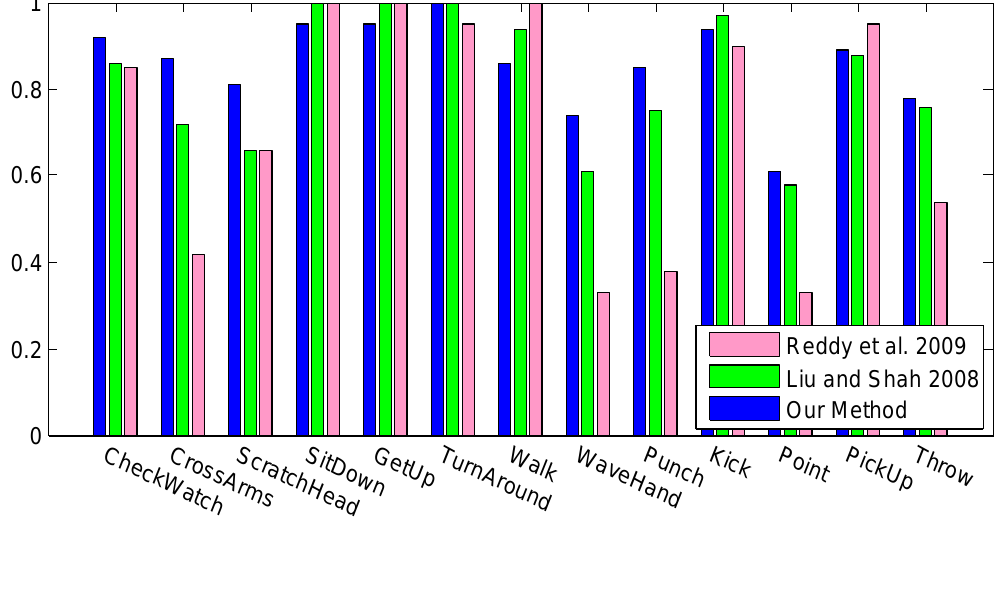
Figure 9. Class-level recognition results of the IXMAS dataset with 13 actions, in comparison with Reddy et al . [48] and Liu and Shah [47].